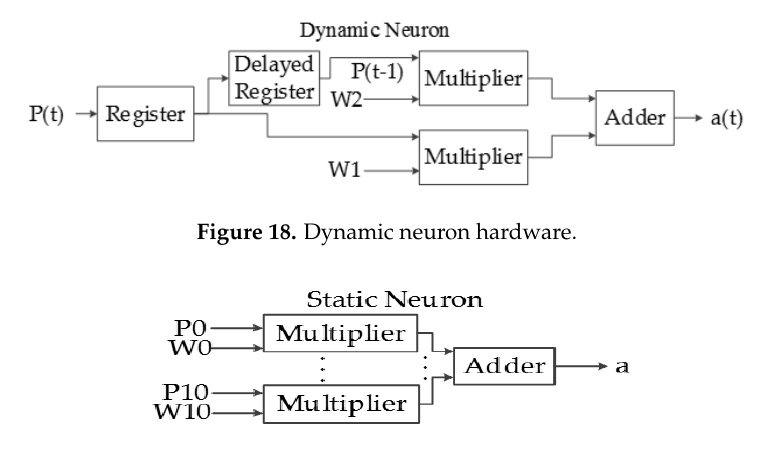
Figure 19. Static neuron hardware.